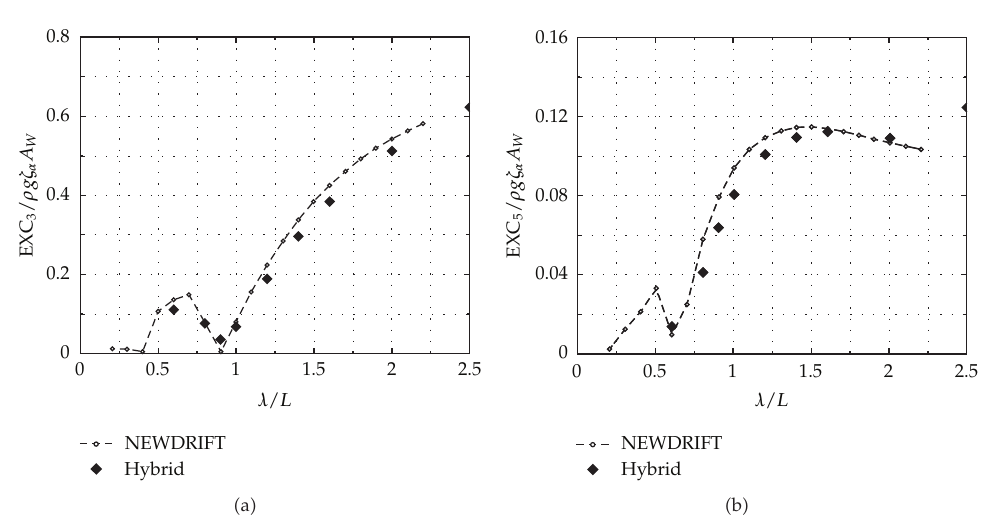
Figure 9: Wave exciting force of S175 ship at F n (cid:7) 0 .